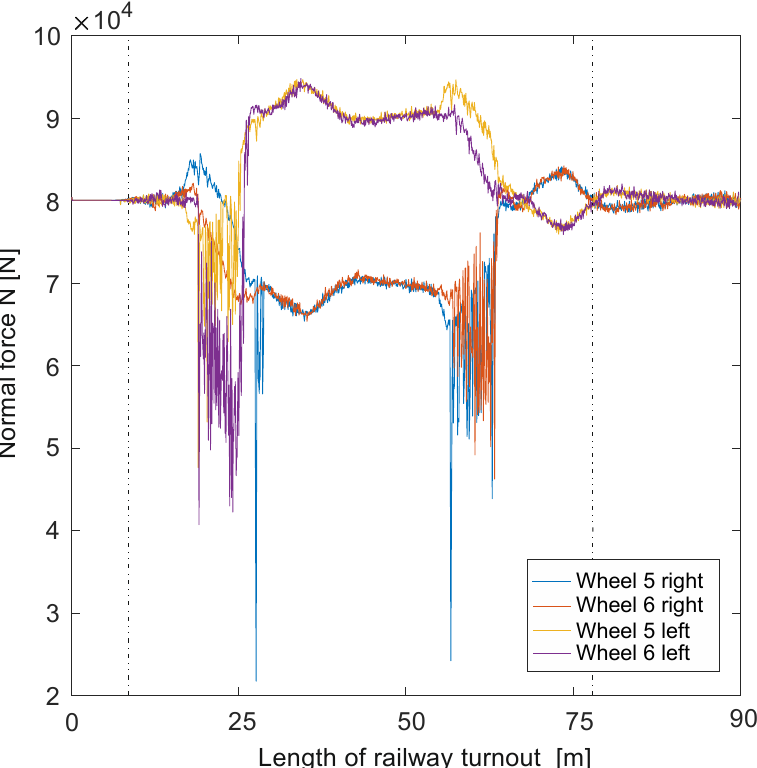
Figure 13. Normal force at 150 km/h on a straight track through a turnout.